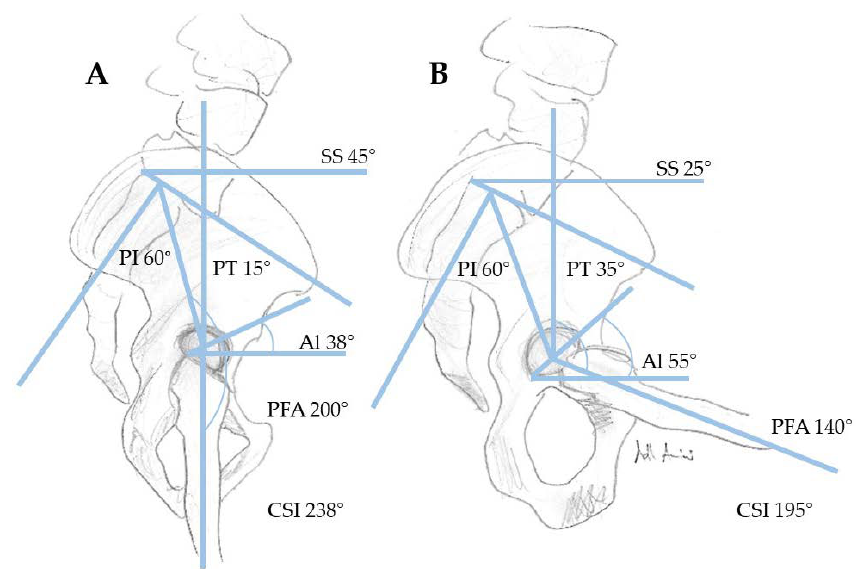
Figure 2. Overview of relevant spinopelvic parameters in standing ( A ) and sitting ( B ) positions with normal spinopelvic motion ((SS, PI (pelvic incidence), AI (anteinclination), PFA (pelvic femoral angle), SS (sacral slope), CSI (combined sagittal index), PT PT (pelvic tilt) (sPT)).